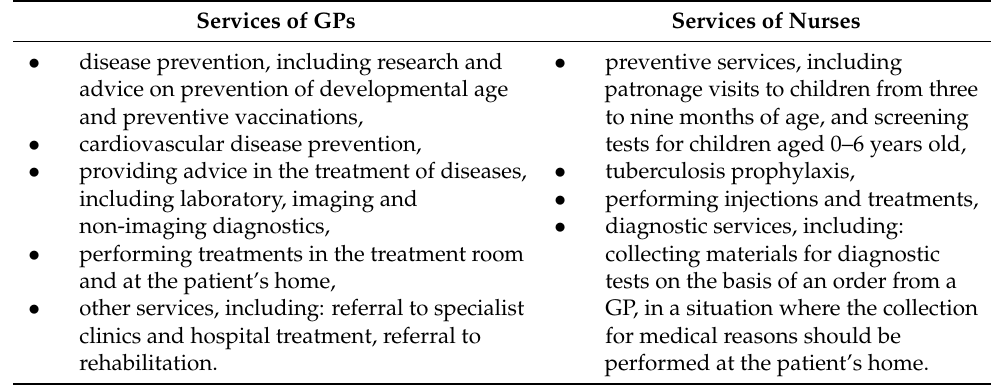
Table 1. The services provided by GPs and nurses in the primary health care system in Poland. Services of